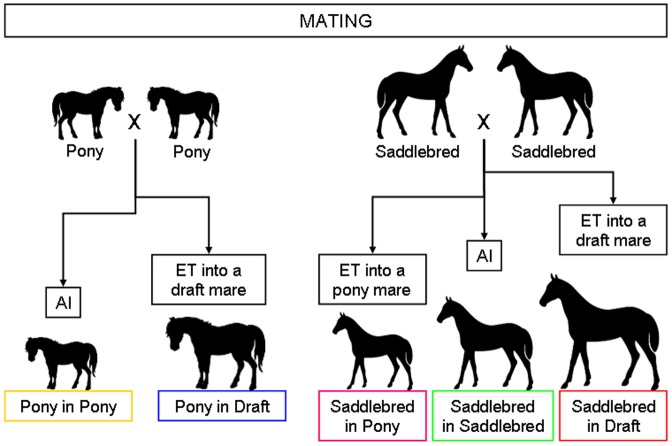
Establishment of control and experimental pregnancies by artificial insemination (AI) and embryo transfer (ET), respectively.